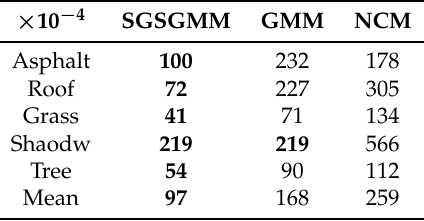
Figure 8. The wavelength reflectance space of the endmember signature estimated for the Gulfport dataset, which has the same meaning as in Figure 5. Table 4. The RMSE calculated between the probability value in each histogram and the estimated value at each bin location for the Gulfport